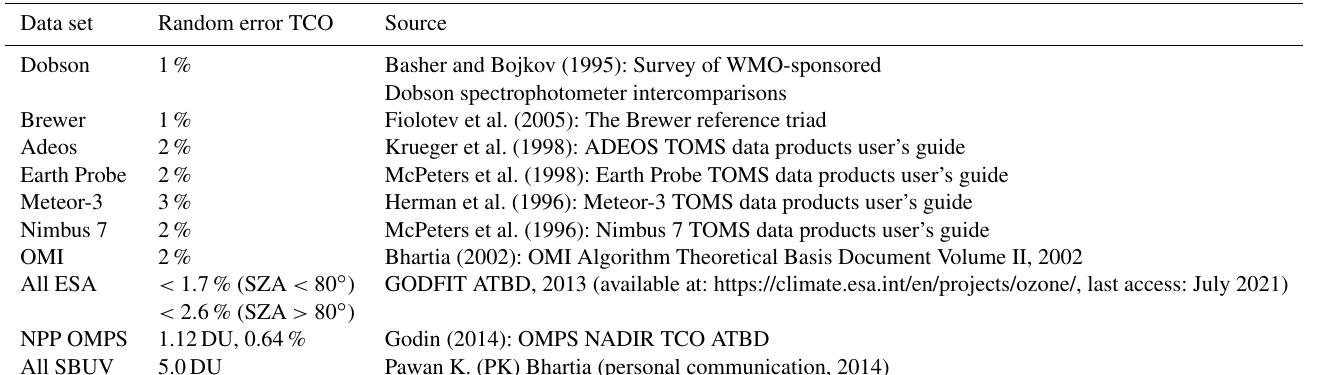
Table 2. Typical uncertainties on the source data sets as reported in the references provided and as used in the construction of the TCO databases. Note that the uncertainty on any particular measurement may differ from the typical values quoted in this table.